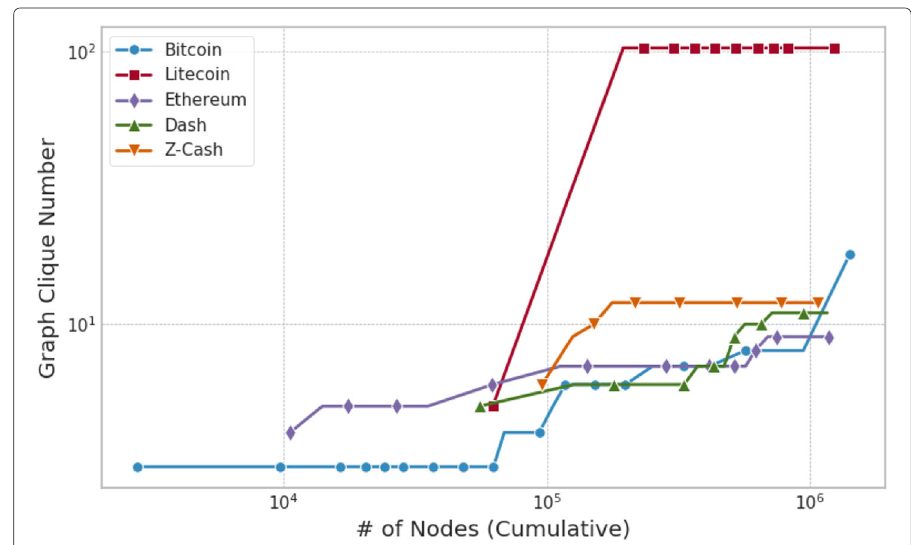
Fig. 9 Maximum clique size of CMTG vs. the number of its nodes